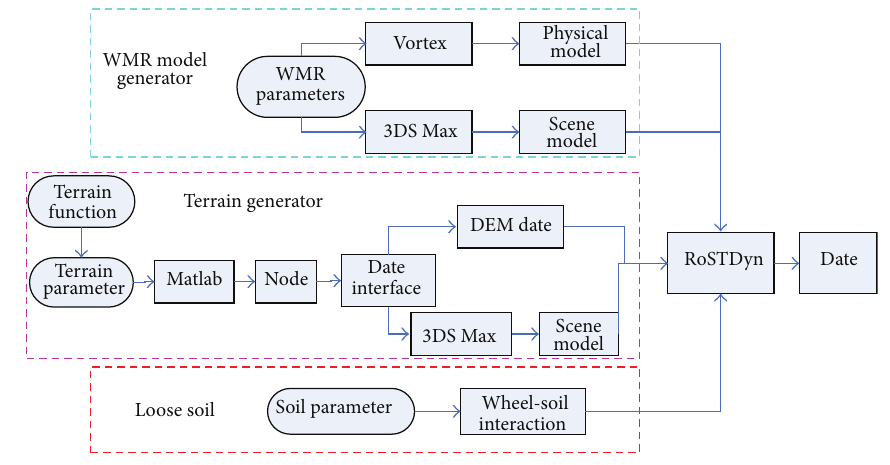
Figure 8: Schematic of simulation using RoSTDyn